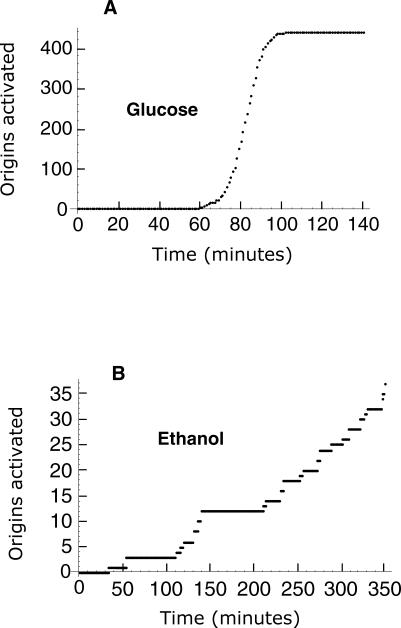
Regulation of Firing of DNA Replication OriginsCumulative number of fired origins during the course of cell cycle was calculated based on the probabilistic model for firing of origins, as explained in Materials and Methods.(A) Cells grown in glucose.(B) Cells grown in ethanol.Note different scales on the y-axis.